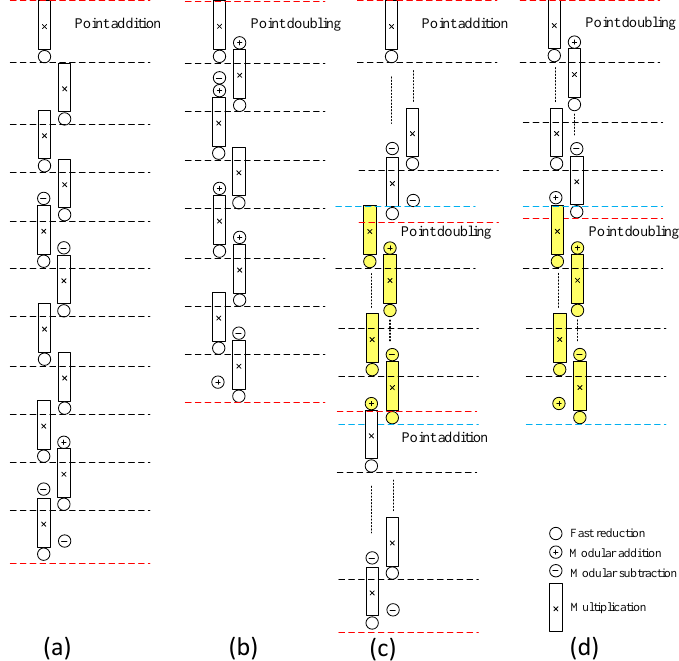
Figure 2. Operational schedule without idle clock cycle: ( a ) point addition; ( b ) point doubling; ( c ) between point addition and point doubling; and ( d ) between point doubling and point